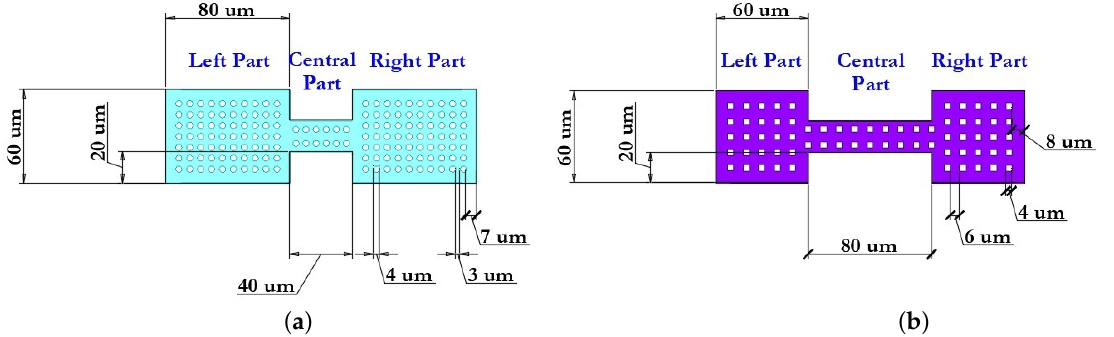
Figure 12. Schematic view of the designs of the movable membranes: ( a ) switch (A); ( b ) switch (B). The conductivity of the RF signal between the input and output of the RF signal line of the CPW depends on the position of the switching movable membrane: for switch (A)—located above the RF signal line of the CPW; for switch (B)—being part of the RF signal line of the CPW. The various geometric dimensions of the movable membranes of the developed capacitive RF MEMS switches are shown in Table